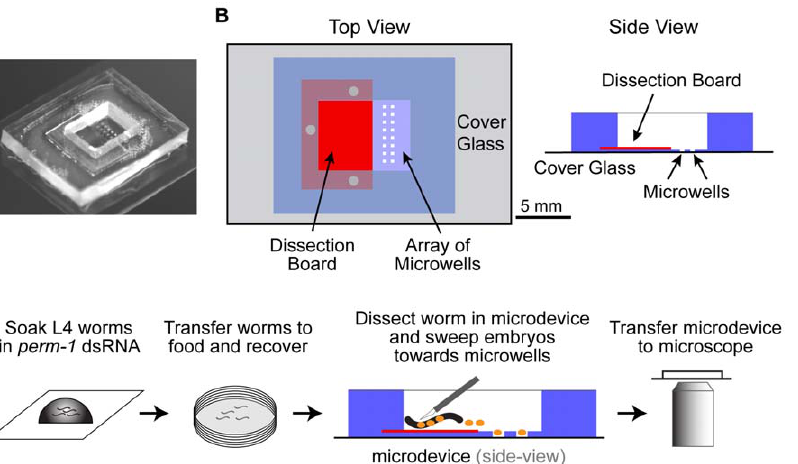
Figure 3. A microdevice that immobilizes permeable embryos for simultaneous imaging and small molecule addition. A. Photograph of the microdevice. B. Schematic drawings of the top and side views of the microdevice. C. Schematic depicting the procedure for preparing permeabilized embryos for drug treatment and imaging. C. elegans hermaphrodites at the L4 larval stage are soaked in a drop of perm-1 dsRNA for 4 hours at 20 u C. The worms are transferred to a plate with bacteria and allowed to recover for 16 hours at 16 u C. 1–3 worms are placed on the dissection board of the microdevice after filling it with , 100 m l of media. Worms are dissected with a scalpel and the released early embryos are swept into the microwells with an eyelash tool. The microdevice is transferred to the microscope and the embryos are imaged. When the desired stage is reached, the medium in the microdevice is replaced with fresh medium containing the drug of interest. doi:10.1371/journal.pone.0024656.g003 PLoS ONE |